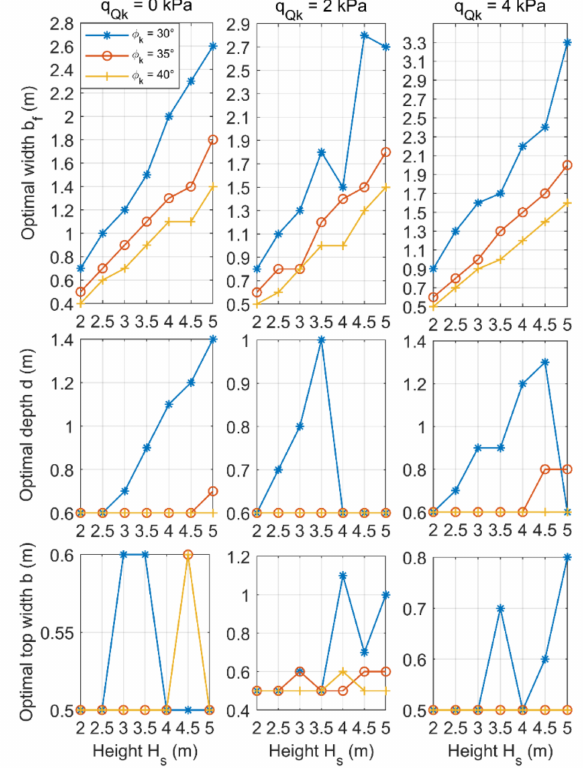
Figure 6. Optimal design for k = 2/3, β = 0 ◦ and γ = 18 kN/m 3 .